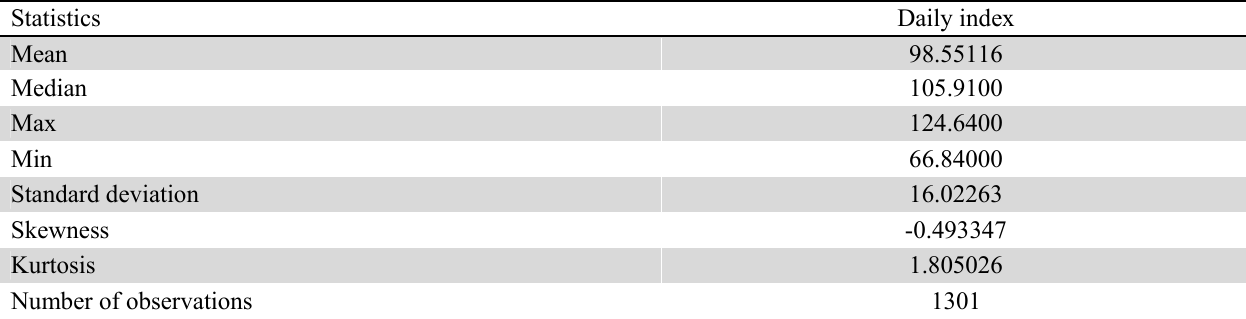
The summary of some basic statistics on oil price